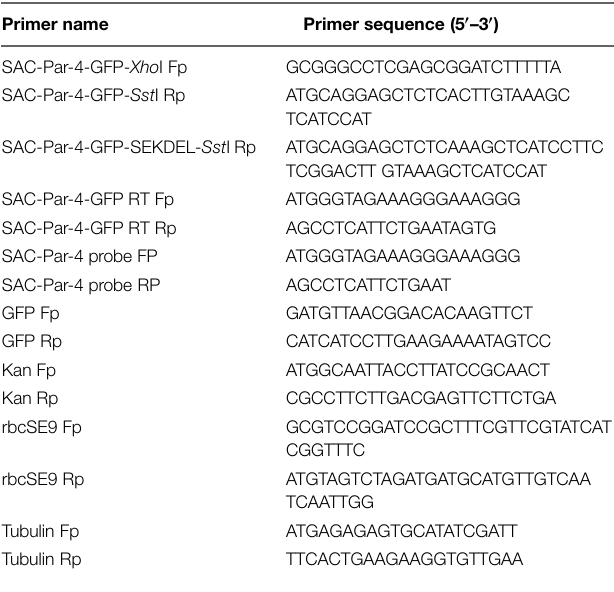
TABLE 1 | List of Primers used. Primer